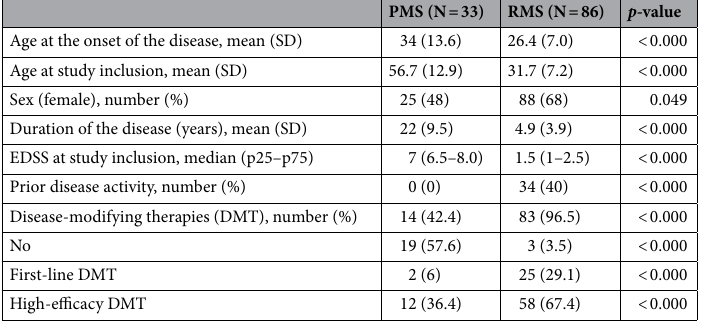
Table 1. Demographic and clinical features of patients in the cohort of the study. N, number of patients; PMS, progressive multiple sclerosis; RMS, relapsing multiple sclerosis; EDSS, expanded disability status scale; DMT, Disease-modifying therapies; NA, not-available. Significant values are in bold.